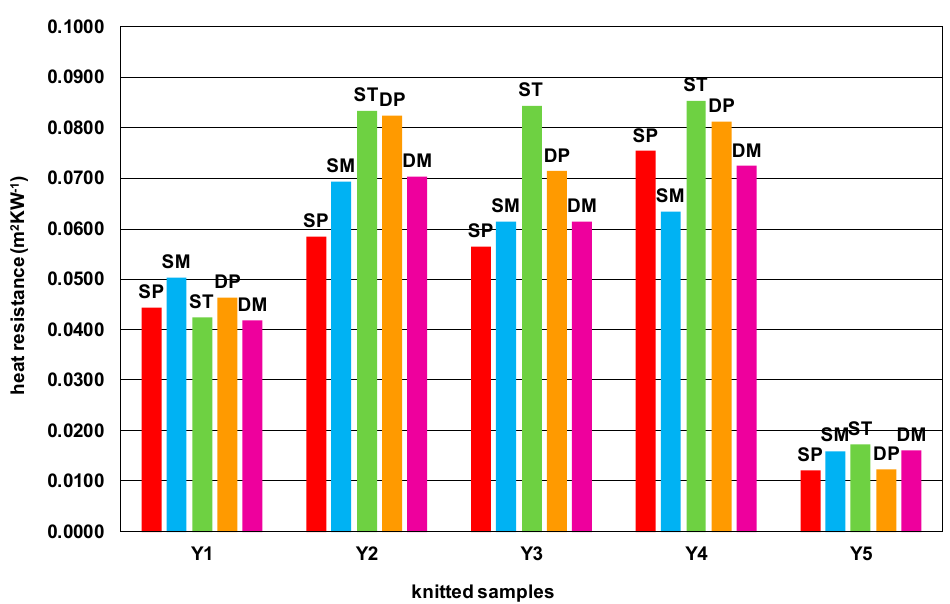
Figure 1. Heat resistance of knitted samples in different single and double structures.